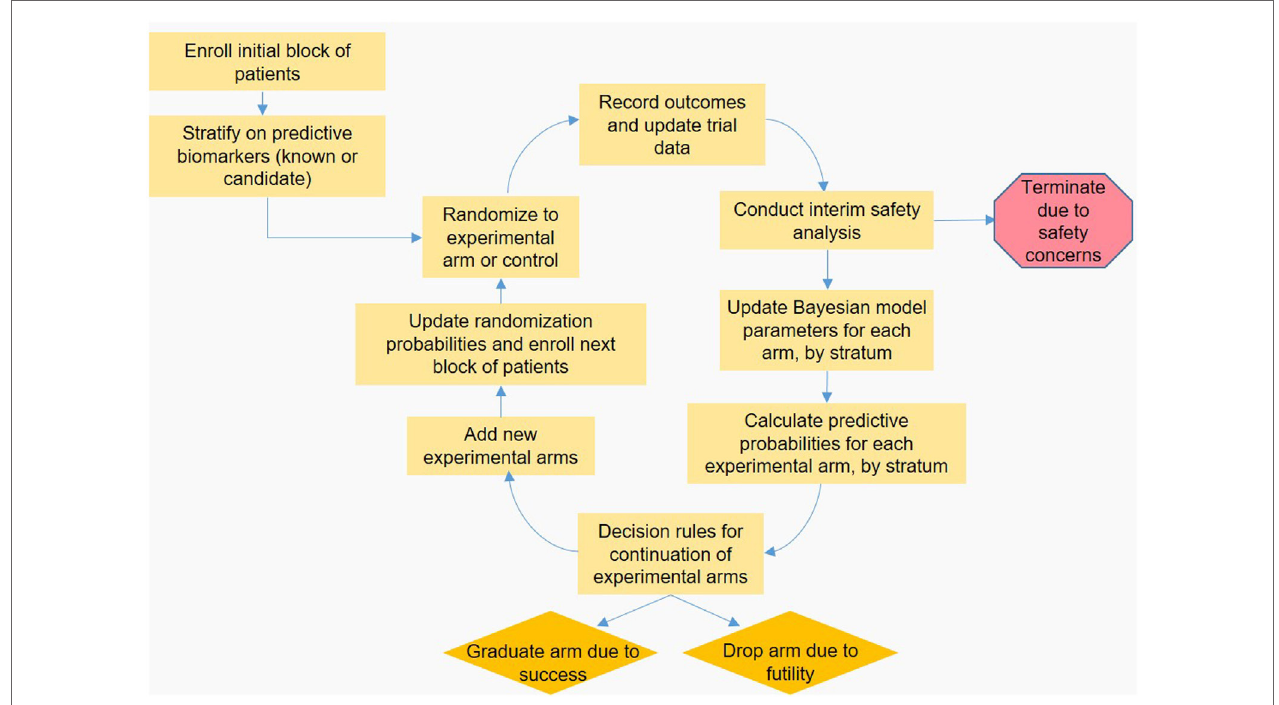
FiGURe 1 | Schematic representation of a hypothetical adaptive platform trial. An initial block of patients is stratified based on known or candidate predictive biomarkers, and then randomized to an experimental or control arm. Once a predefined number of patients is enrolled, outcomes are observed and the data are input to the Bayesian statistical model by arm and stratum, which is used to calculate the predictive probabilities (PP) that each experimental arm will be superior to control in the final analysis. These PP are checked against predefined decision boundaries established so that arms with poor probability of success are dropped, and arms with high probability of success “graduate” to the next phase of testing. Arms with PP that do not require dropping or graduation continue enrolling subjects; arms that are removed may be replaced by new experimental treatments, accrual permitting. Finally, the PP are used to update randomization probabilities used for the next block of patients to be enrolled, and the feedback loop begins